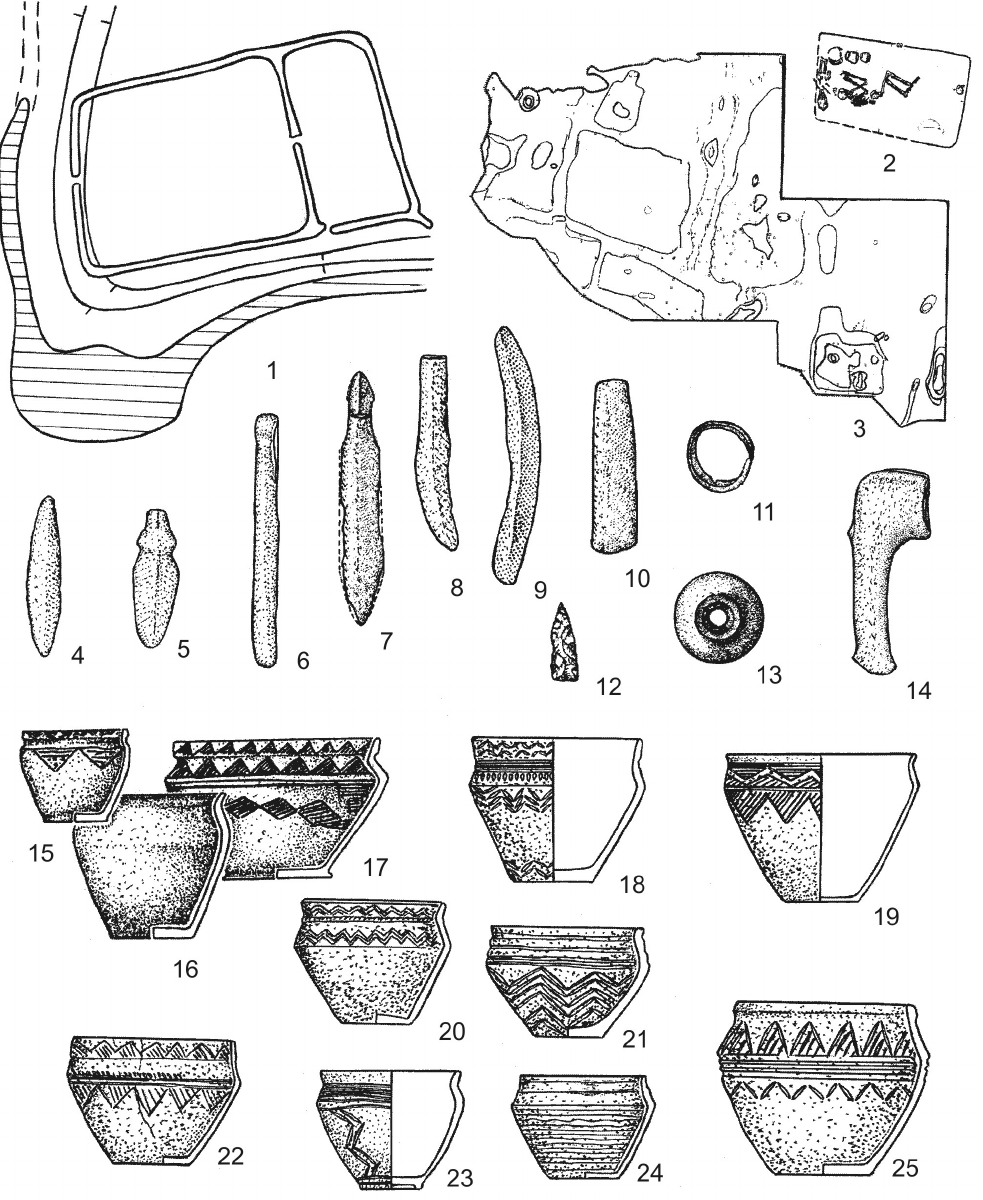
Figure 9: Petrovka culture: 1 – Petrovka II; 2, 15–17 – Bolshekaragansky cemetery; 3, 4–6, 8, 14, 18, 20, 22–24 – Kulevchi; 7, 10–13, 19, 21, 25 – Berlik; 9 – Kamyshnoe II (1 – after Zdanovich, 1988; 2, 15–17 – after Botalov, Grigoriev, & Zdanovich, 1996; 3, 4-6, 8, 14, 18, 20, 22-24 – after Vinogradov, 1982; 9 – after Potemkina,